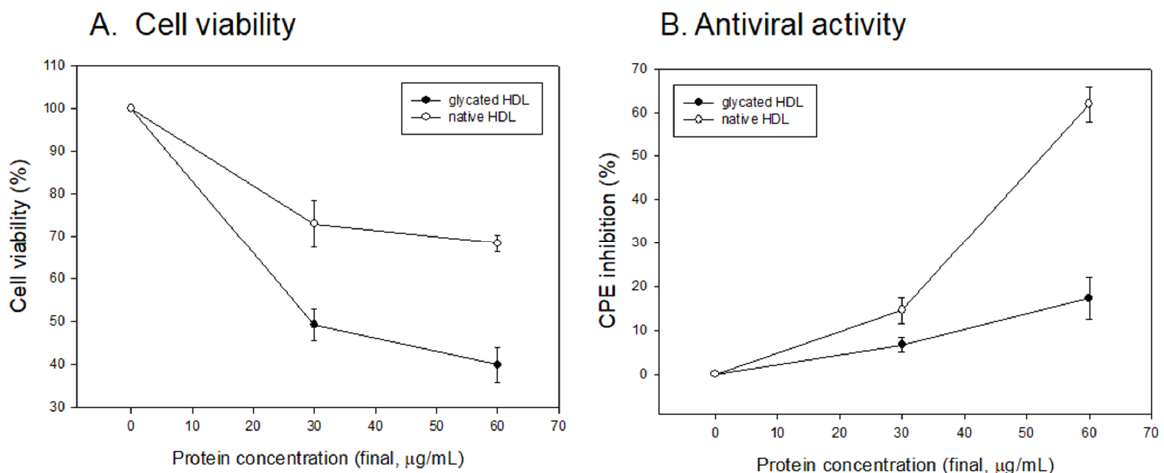
Figure 4 . Comparison of glycated HDL and native HDL . ( A ) Cell viability of Vero E6 cell after Figure 4. Comparison of glycated HDL and native HDL. ( A ) Cell viability of Vero E6 cell after treatment with lipoproteins. MTT cytotoxicity assays were carried out using uninfected Vero E6 cells with increasing concentrations of each lipoprotein. ( B ) Cytopathic effect (CPE) reduction activity of lipoproteins against